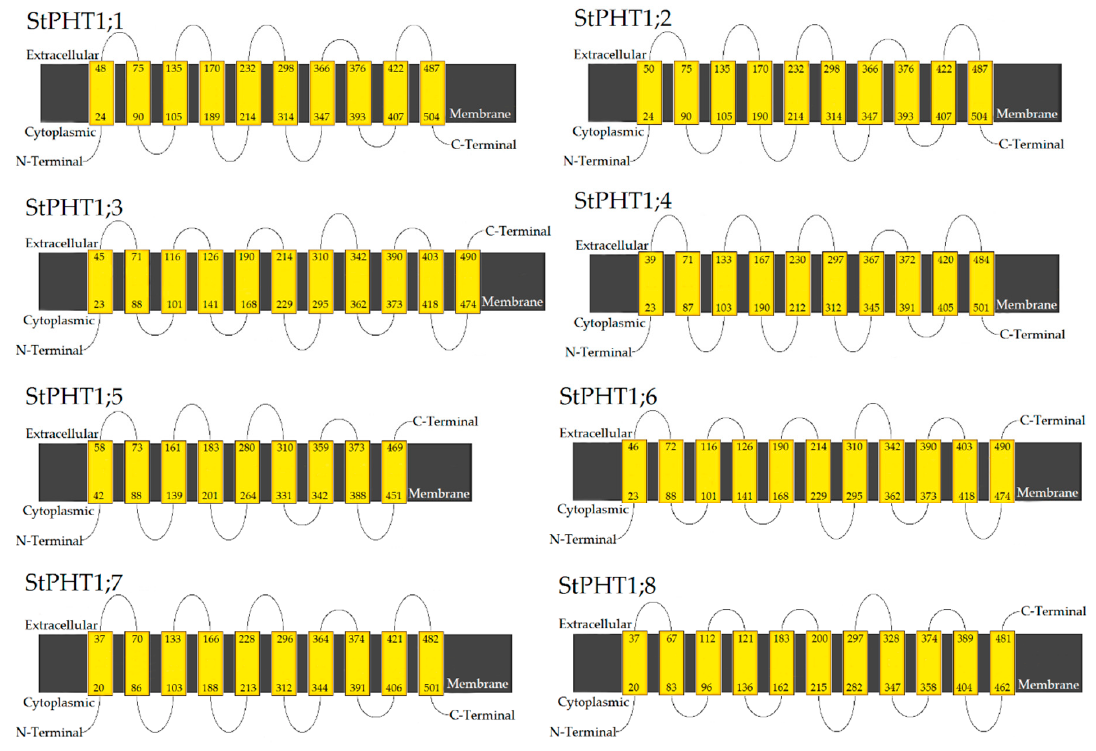
Figure 4. Prediction of the transmembrane domain of the potato PHT1 gene family. The numbers at the top and bottom of the yellow boxes indicate where the polypeptide chain is transmembrane.